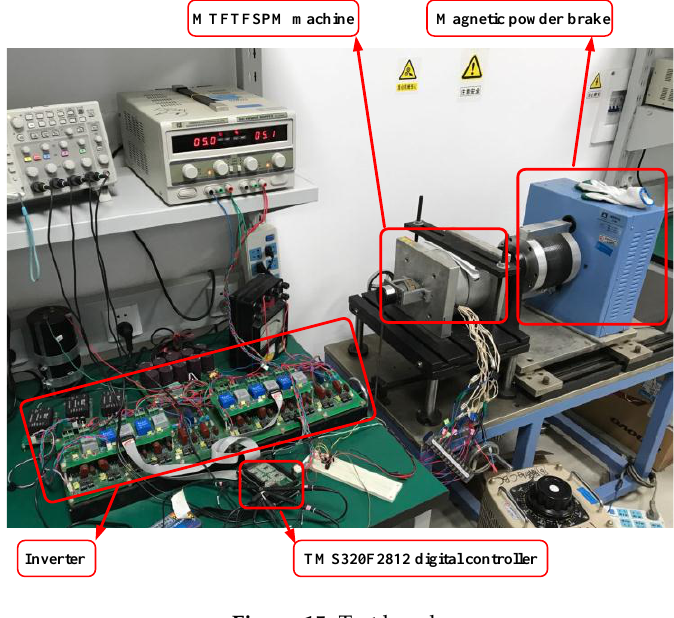
Figure 15. Test bench.